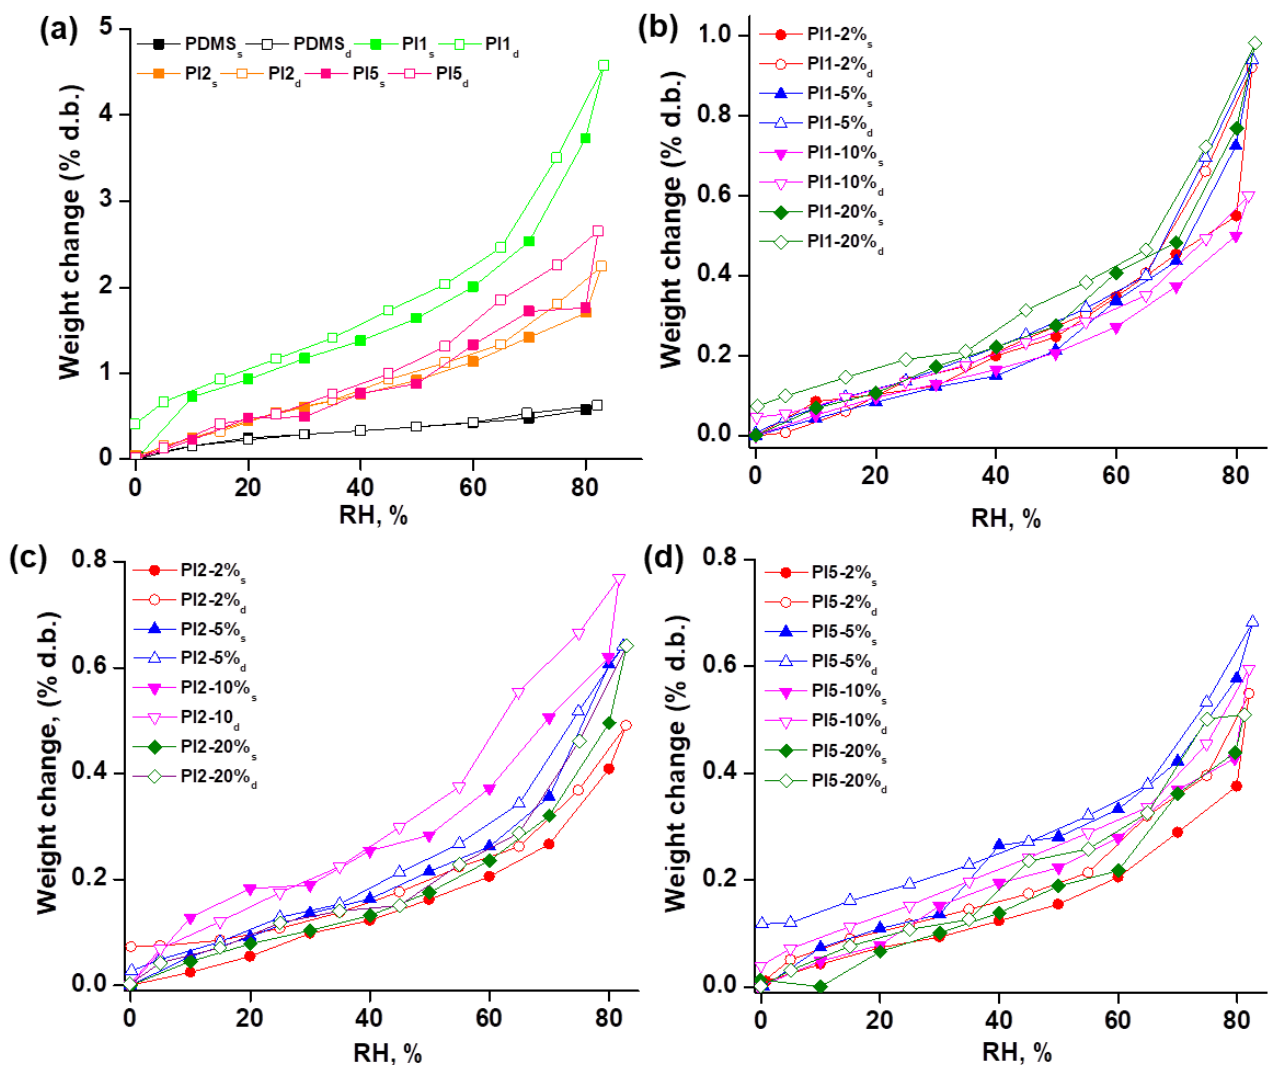
Figure 2. Water vapor sorption capacity for: ( a ) reference samples; ( b ) PI1; ( c ) PI2; ( d ) PI5 composite series, where s and d subscript coefficients represent the sorption and desorption isotherms.